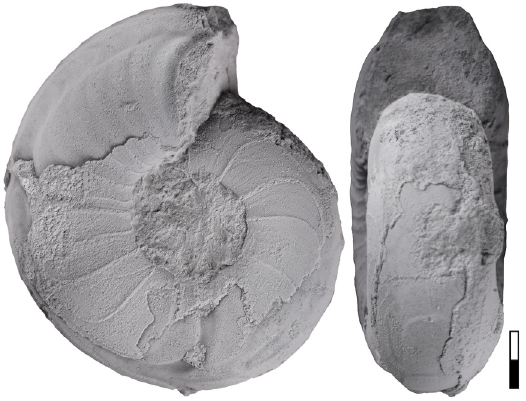
Fig. 9. Paucitornoceras paucistriatum (d’Archiac & de Verneuil, 1842); MB.C.30414 (Koch Coll.) from Oberscheld. Scale bar units = 1